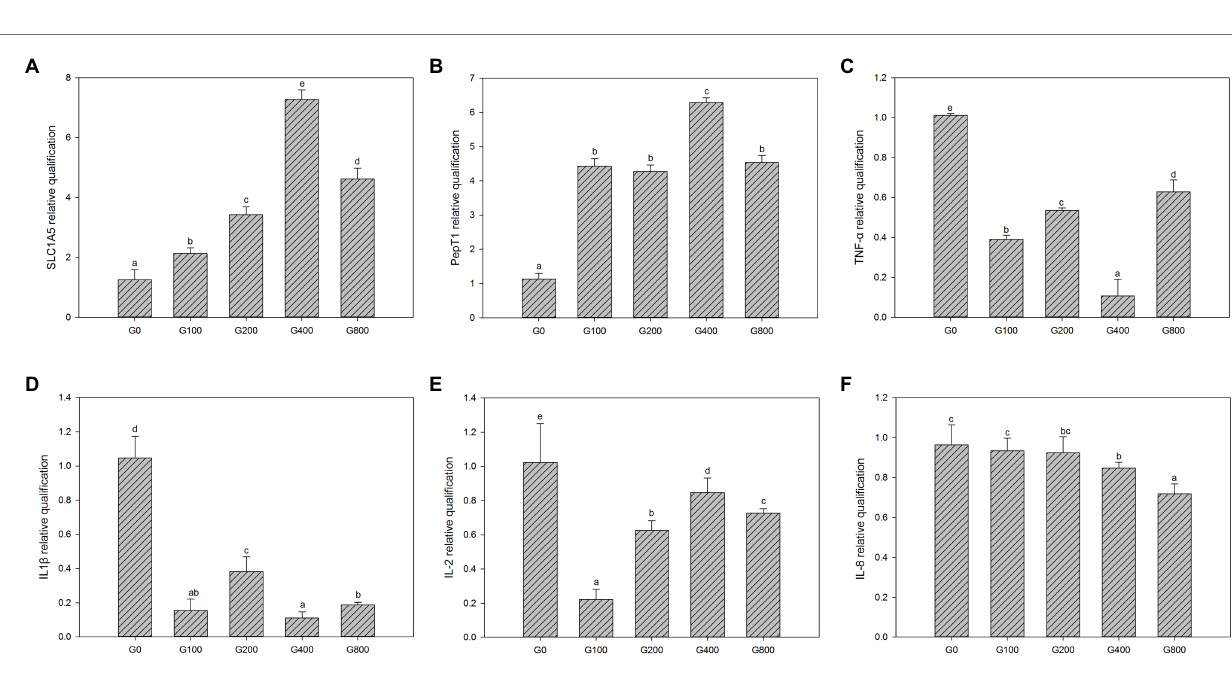
species. There was no significantly different effect of GSH on the